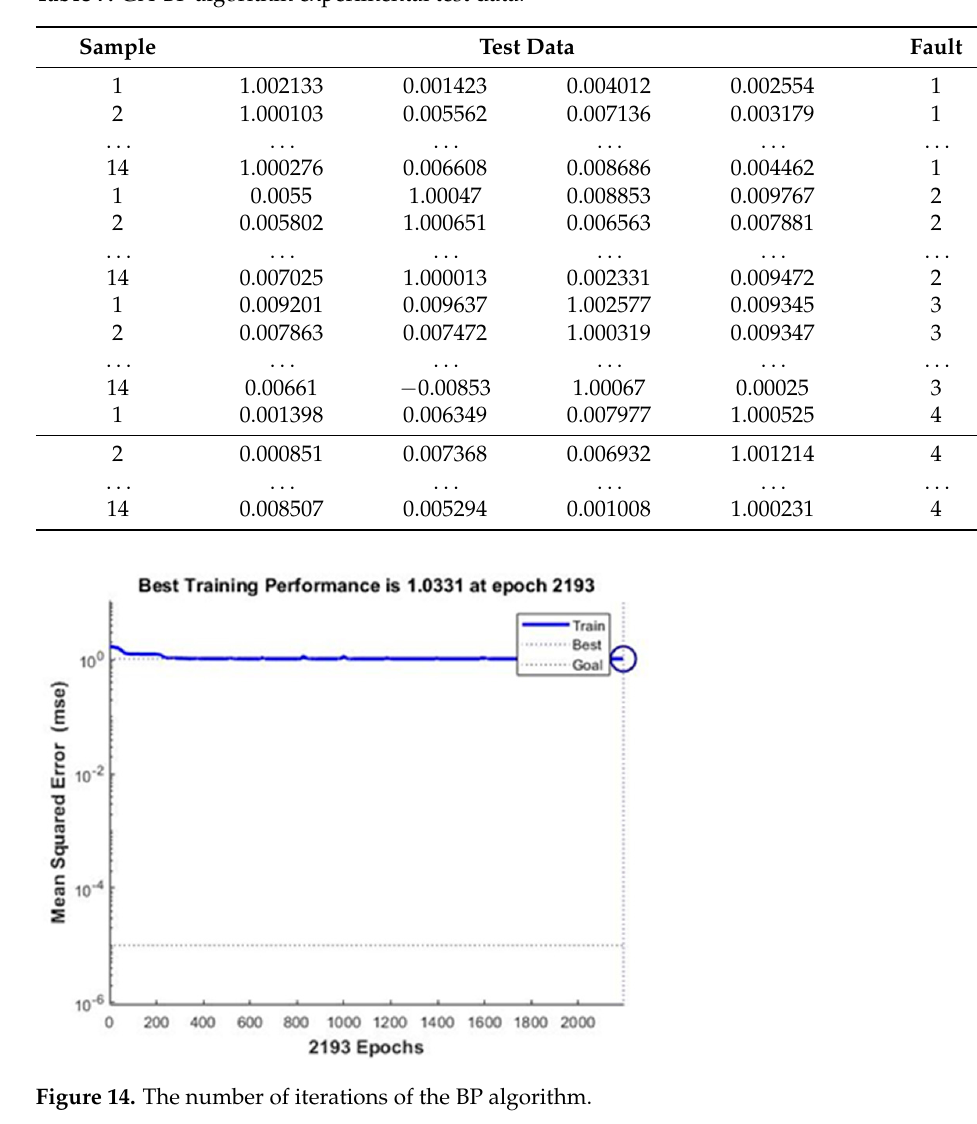
4 Table 7. GA-BP algorithm experimental test data.